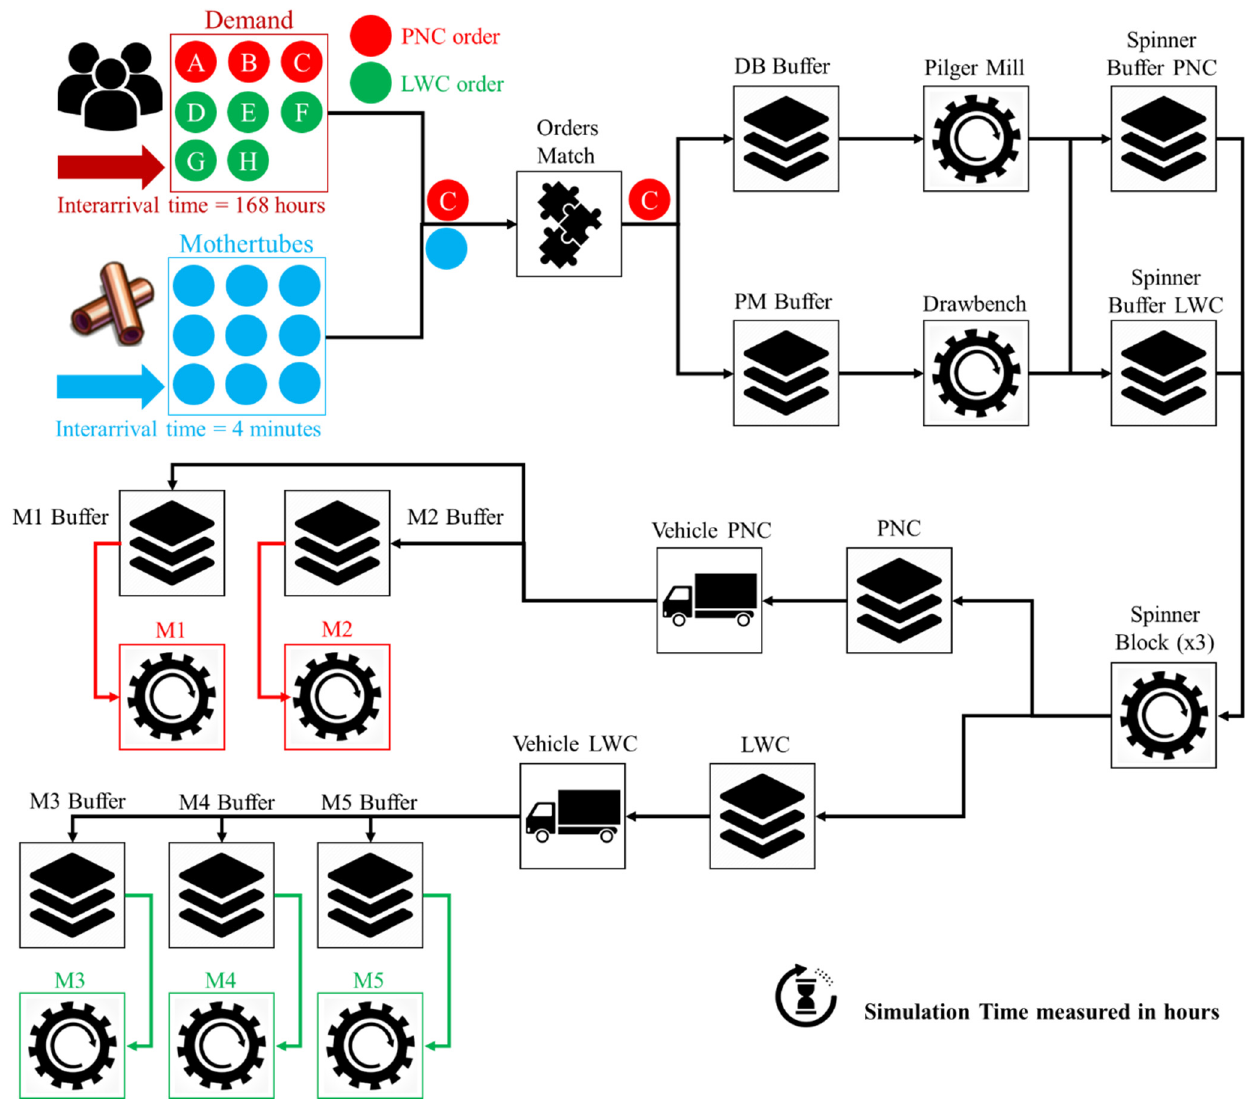
Figure 5. Structure of the simulation model.